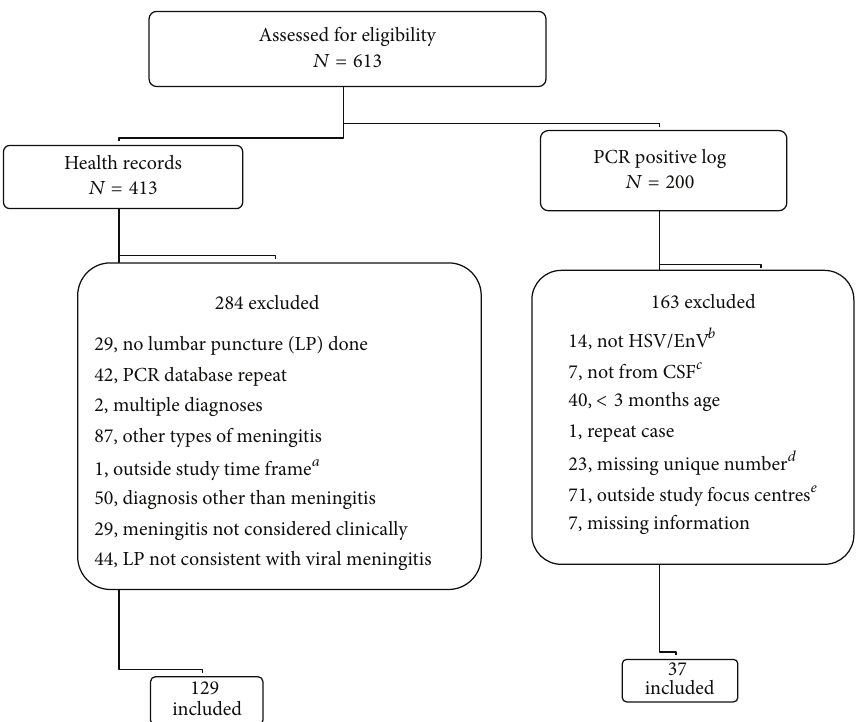
Figure 1: Patient flow diagram. PCR: polymerase chain reaction, HSV: herpes simplex virus, EnV: enterovirus, a : case prior to enrollment period of January 2005 to December 2011; b : further breakdown includes two human herpes virus 6, nine varicella zoster virus, one Epstein- Barr virus, one cytomegalovirus, and one toxoplasmosis; c : further breakdown includes four eye fluids, one nasopharyngeal, one brain biopsy, and one lymph node biopsy; d : hospital identification number missing from regional laboratory record, unable to cross-reference to patient’s chart; e: patients from regional hospitals other than those included in the